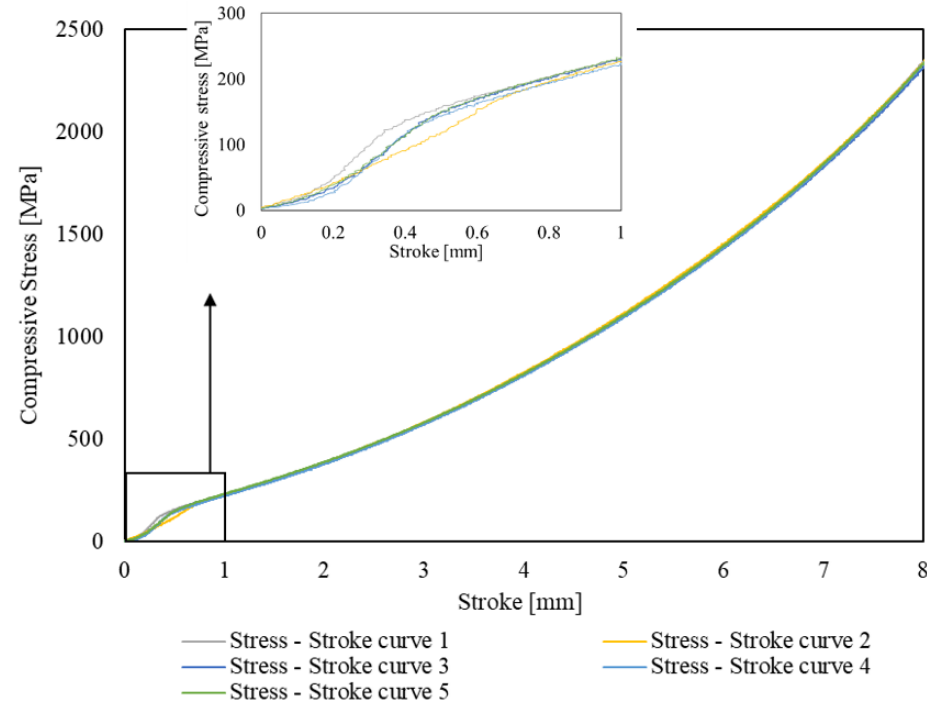
Figure 4. Compressive stress–stroke curves.